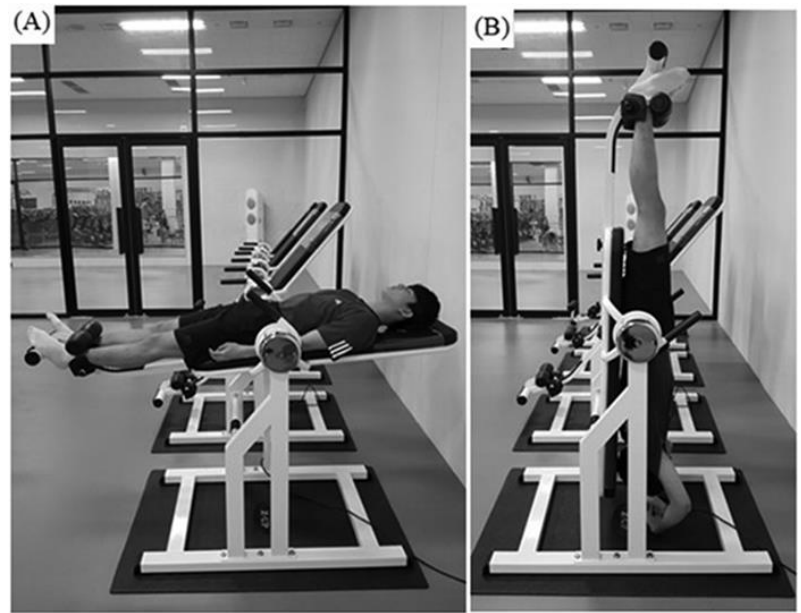
Figure 2. The inverted body position, once subjects moved from ( A ) a supine position to ( B ) the IBP, 30 s were counted and then they were returned to the starting position ( A ). It took 17 s to move from position A to B or vice versa. Subjects then spent about 13 s in the IBP ( B ) before returning to position ( A ).